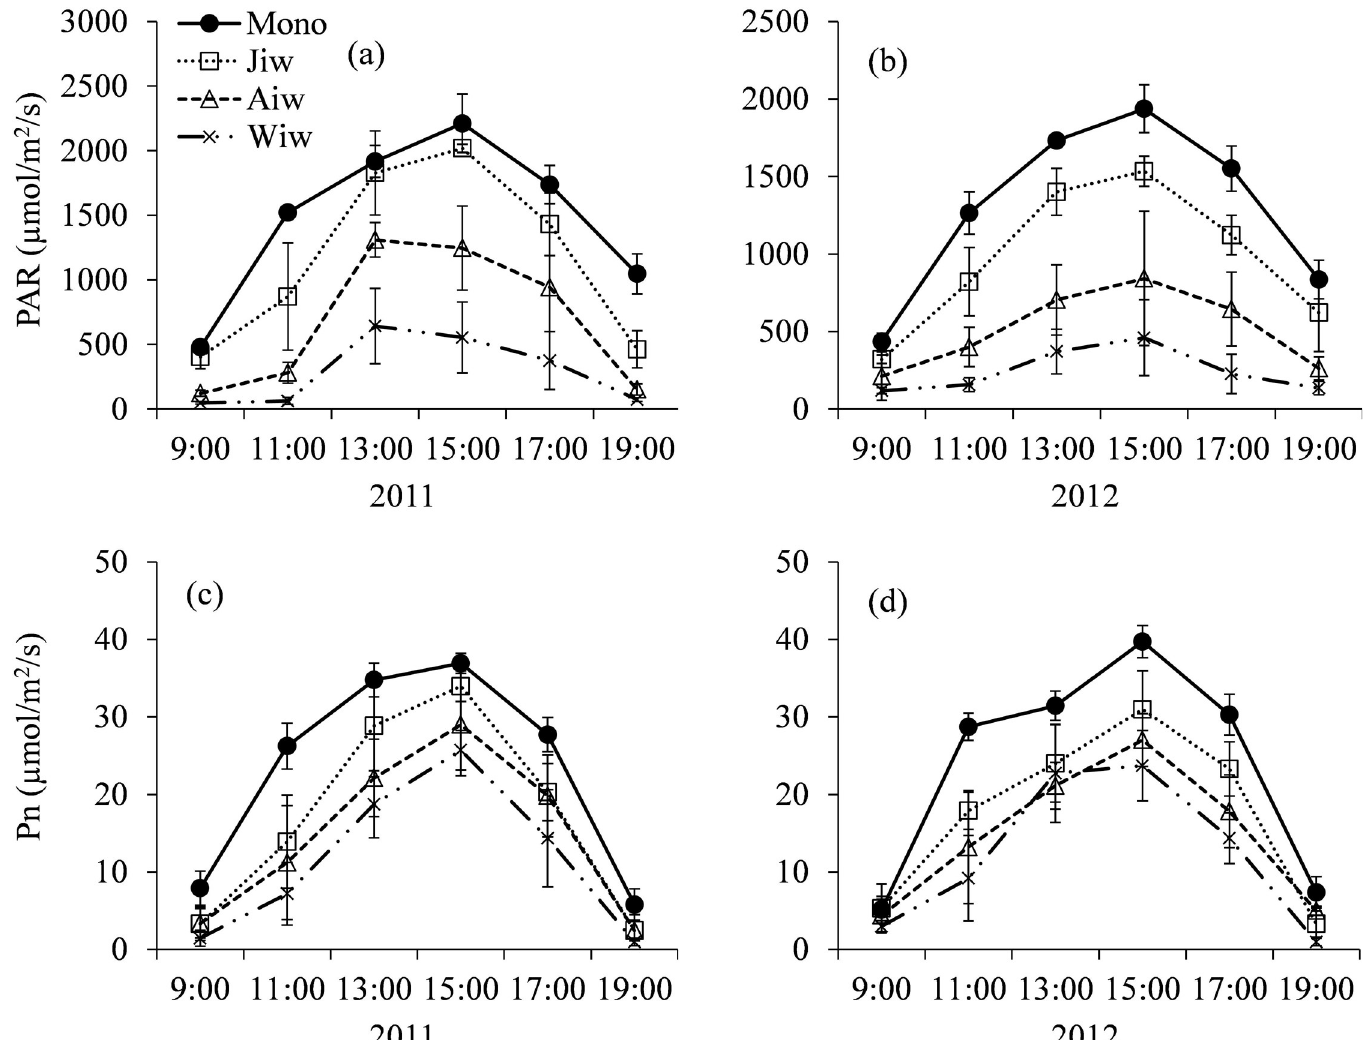
Fig 2. The daily change of photosynthetically active radiation (PAR) and photosynthetic rate (Pn) of wheat in monoculture configurations and 3 different fruit tree-wheat intercropping systems at the filling stage in 2011 (a, c) and 2012 (b, d). The PAR and Pn data are the mean values of the three regions, in the middle region of the tree rows, under the tree of east canopy and west canopy, respectively. Mono, monoculture wheat system; Jiw, jujube-wheat intercropping system; Aiw, apricot- wheat intercropping system; Wiw, walnut-wheat intercropping system.